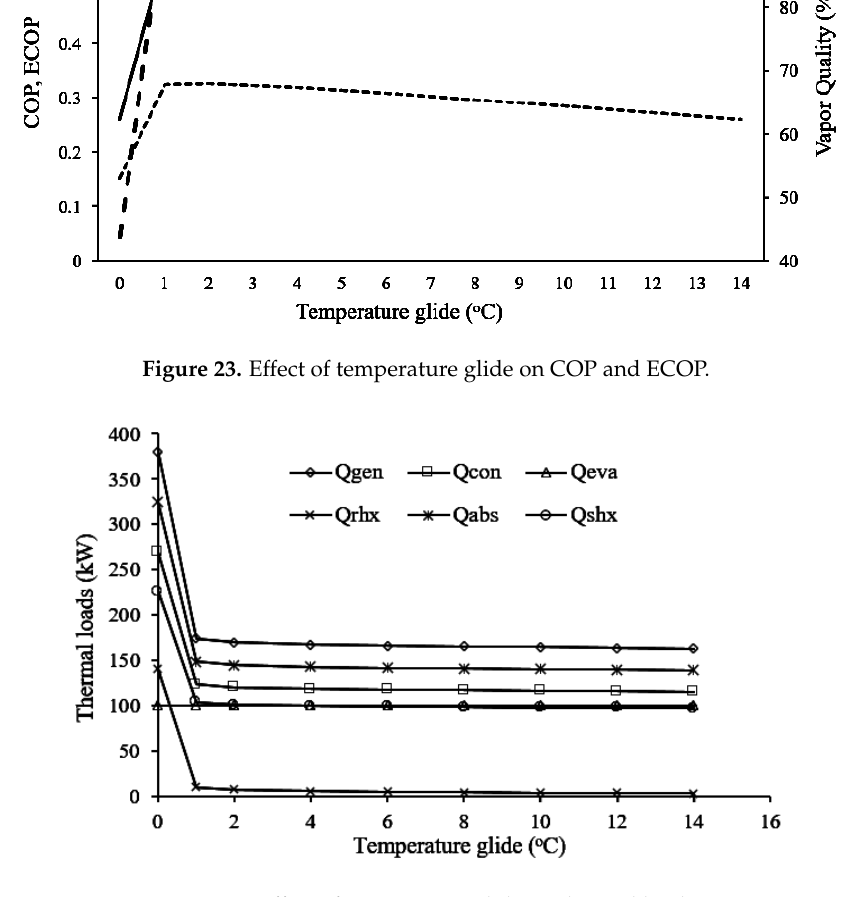
Figure 24. Effect of temperature glide on thermal loads.